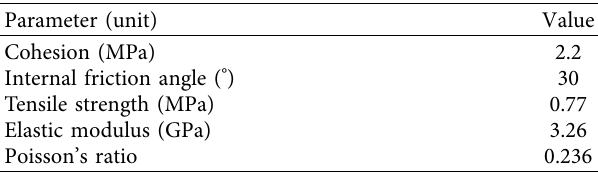
Figure 1: Schematic diagram of the model and monitoring points. Table 1: Mechanical parameters of the model.